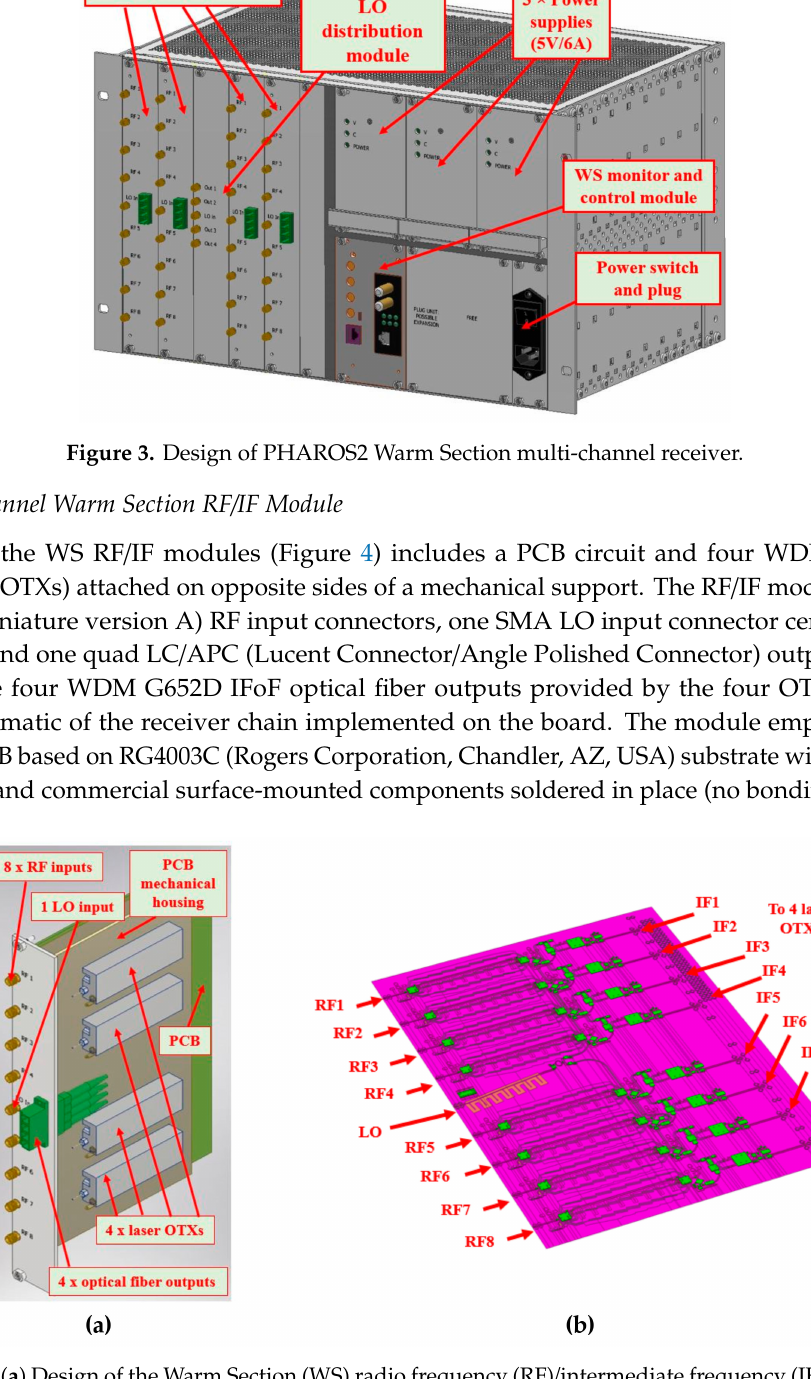
Figure 4. ( a ) Design of the Warm Section (WS) radio frequency (RF) / intermediate frequency (IF) module showing the eight RF inputs, the local oscillator (LO) input, the quad Lucent Connector / Angle Polished Connector (LC / APC) fiber-optics connector, the printed circuit board (PCB) and its mechanical housing (left panel); ( b ) Design of the PCB with RF, LO and IF components. The size of the PCB is 160 mm × 233.35